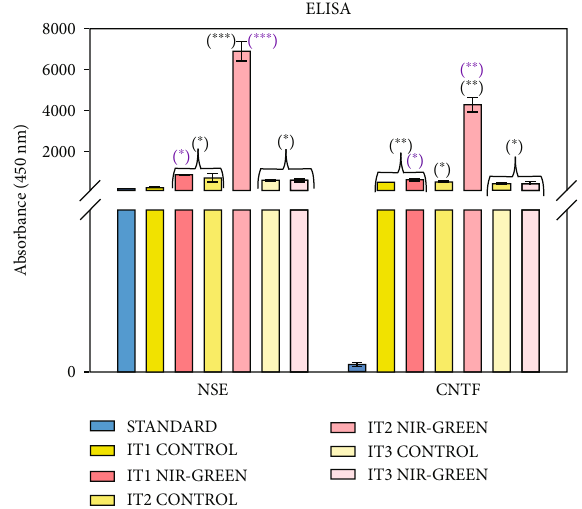
Figure 10: Protein detection ELISA results of IT3 transdi ff erentiated iADSCs using NSE and CNTF 7 days following PBM. All treated iADSCs showed an increase in NSE and CNTF expression compared to the standard and control